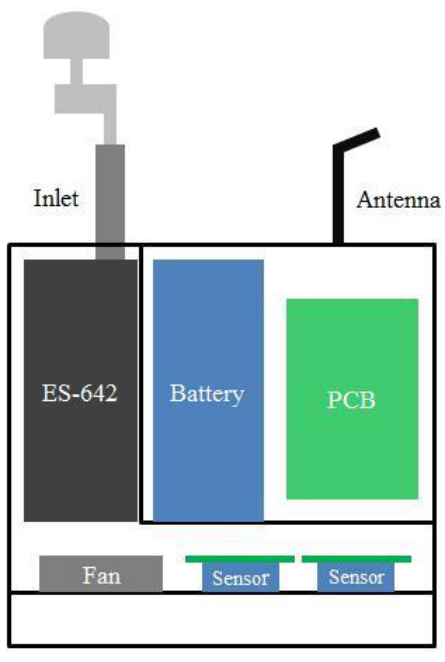
Figure 1. Schematic of the mini air station (MAS) system with different components. Table 1. Specifications of NO 2 and CO sensors, ES-642 and portable ozone monitor (POM).